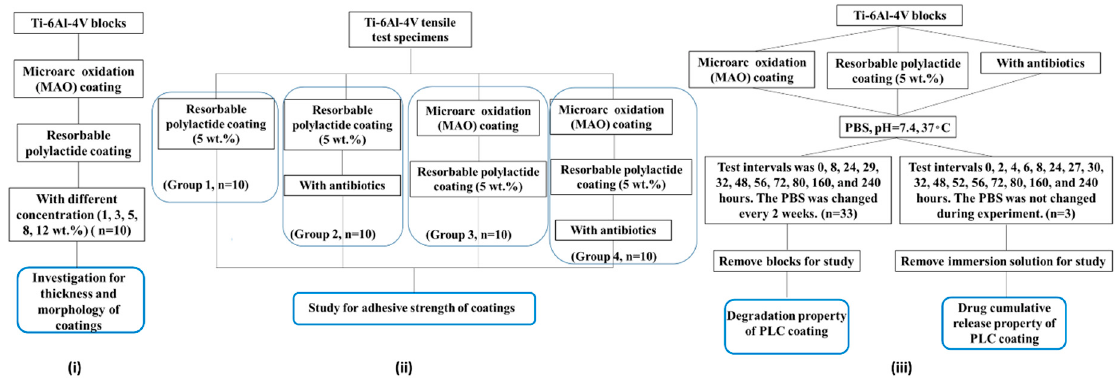
Figure 1. Diagrams of the experimental design.